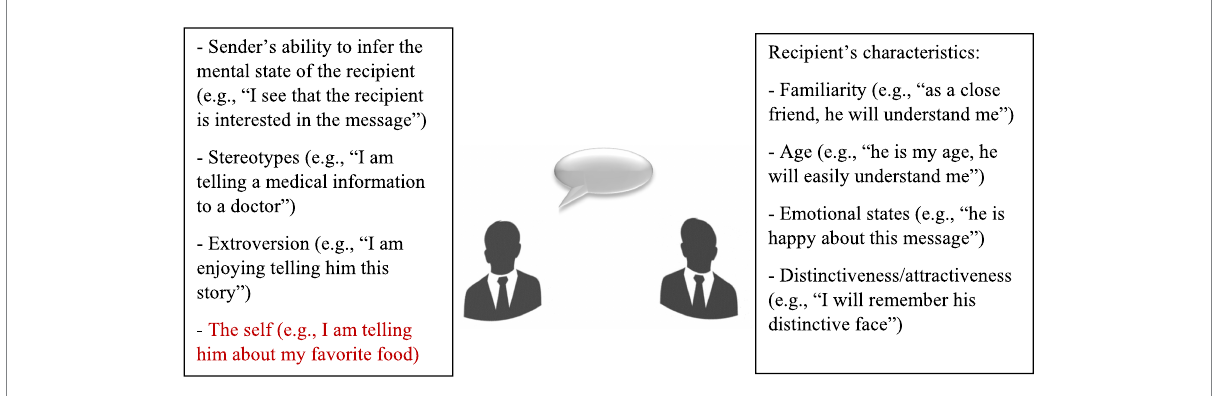
FIGURE 1 How we retain destination during a conversation When sending a message, the sender can associate the information with the mental/affective state of the sender or with stereotypes related to the recipient. The sender’s extroversion, and the self, may also facilitate retention. For better retention, the sender may also rely on the recipient’s